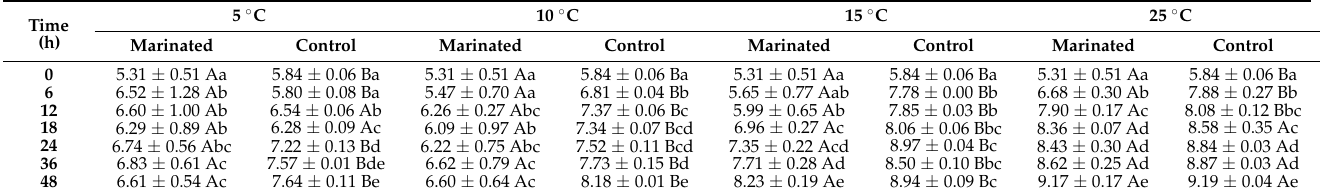
Table 2. Total viable count, TVC (log CFU/g) of cinnamon-marinated meat and control (non- marinated meat) stored at 5, 10, 15, and 25 ◦ C.